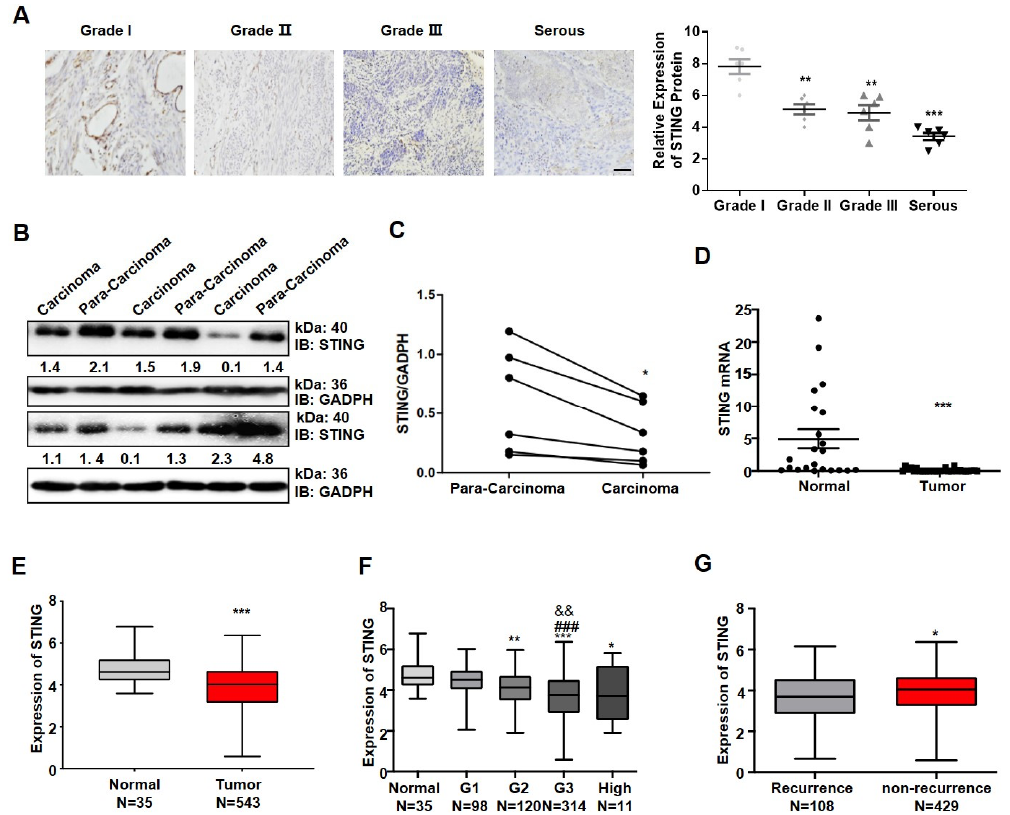
Figure 1. The STING expression is suppressed in endometrial carcinoma tissues. ( A ) Representative immunohistochemical images and the quantification of STING expression levels during various stages of endometrial cancer patients. Original magnification 200 × . Scar Bar = 50 μ m. ( B ) IB analysis of STING expression levels in various EC tissues lysis. GAPDH was used as a loading control. ( C ) Western blot quantifications of STING protein expression in Figure 1B. ( D ) RT-qPCR analysis of STING RNA in EC tissues (n = 22) and normal tissues (n = 27). ( E ) Relative expression of STING in EC tissues (n = 543) and normal tissues (n = 35) in TCGA databases. ( F ) Analysis of the STING expression during various stages of EC patients in TCGA databases. ( G ) The expression of STING in recurrent (n = 108) and non-recurrent (n = 429) EC in the TCGA database. Data are shown as mean ± SD. Two tail t-tests were used to calculate the p -value. * p < 0.05, ** p < 0.001, *** p < 0.0005 significantly different from control, ### p < 0.001 significantly different from G1, and && p < 0.001 significantly different from G3. Original image of Western blot can be found in File S1.